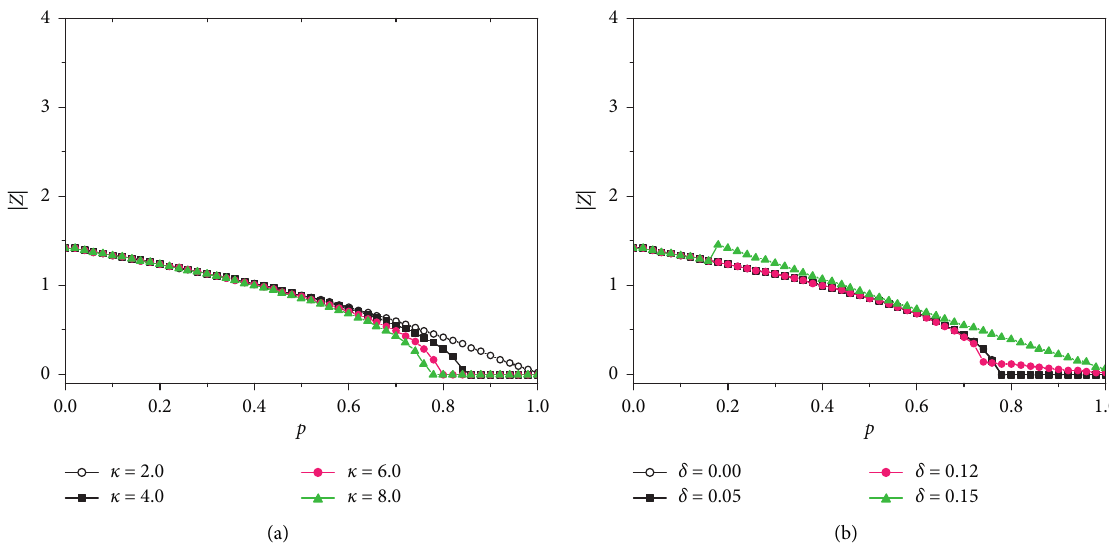
Figure 5: (a) The order parameter | Z | against p with different coupling strength κ . δ � 0 . 1. (b) The order parameter | Z | as a function of the ratio of inactive ratio p for different values of δ . κ � 8 .